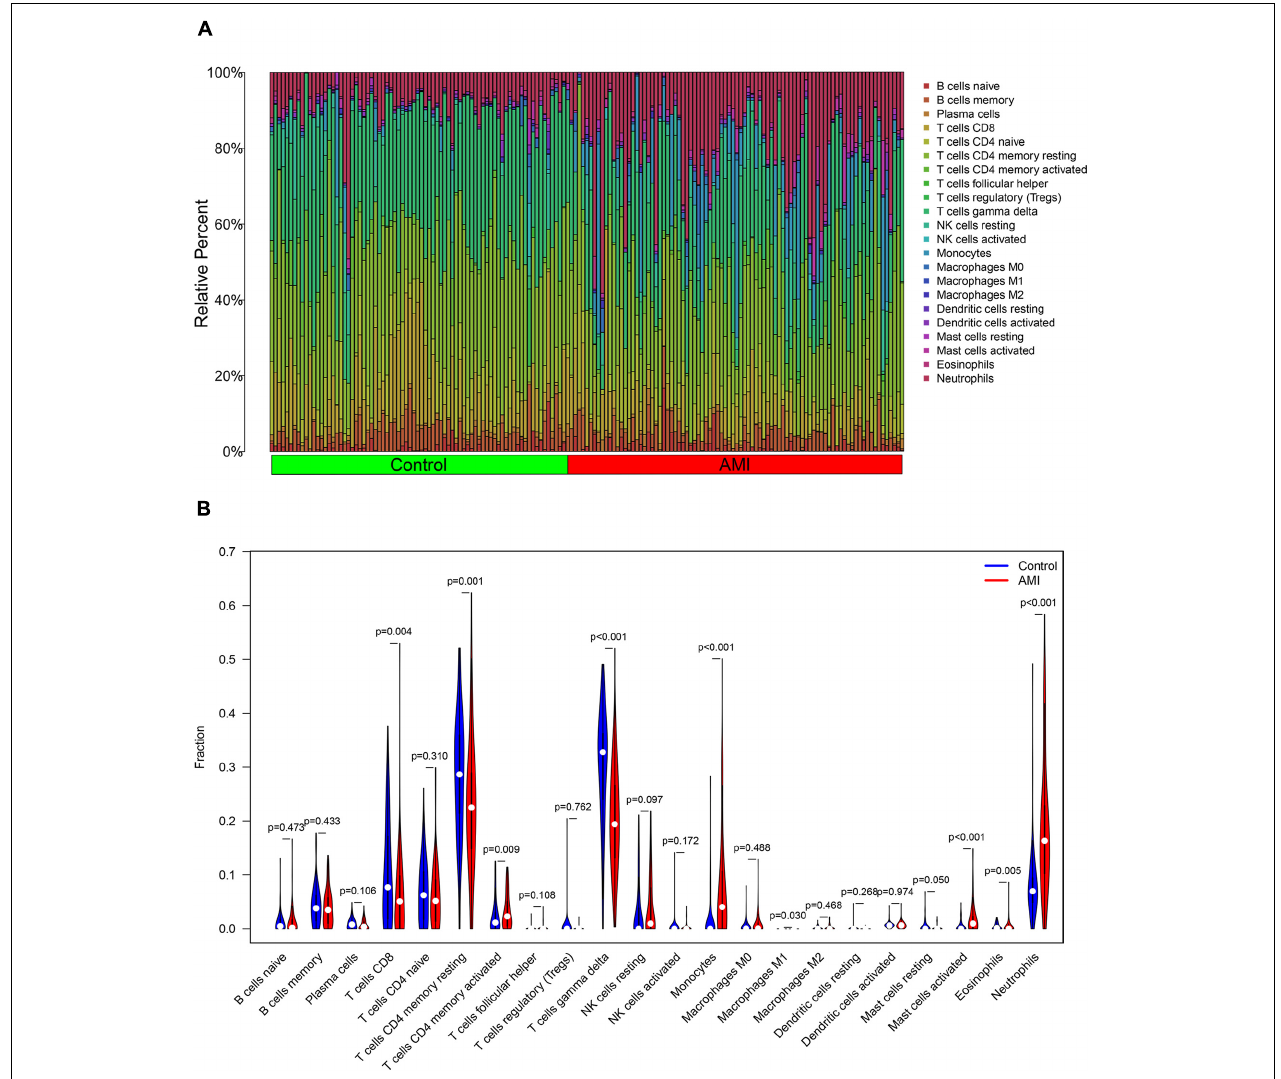
FIGURE 10 | Distribution and visualization of immune cell infiltration. (A) The fraction of 22 subsets of immune cells in AMI and control samples. (B) The violin graph shows the difference of immune infiltration between AMI and control samples. The control samples are shown in blue and AMI samples are shown in red. The value of value p <